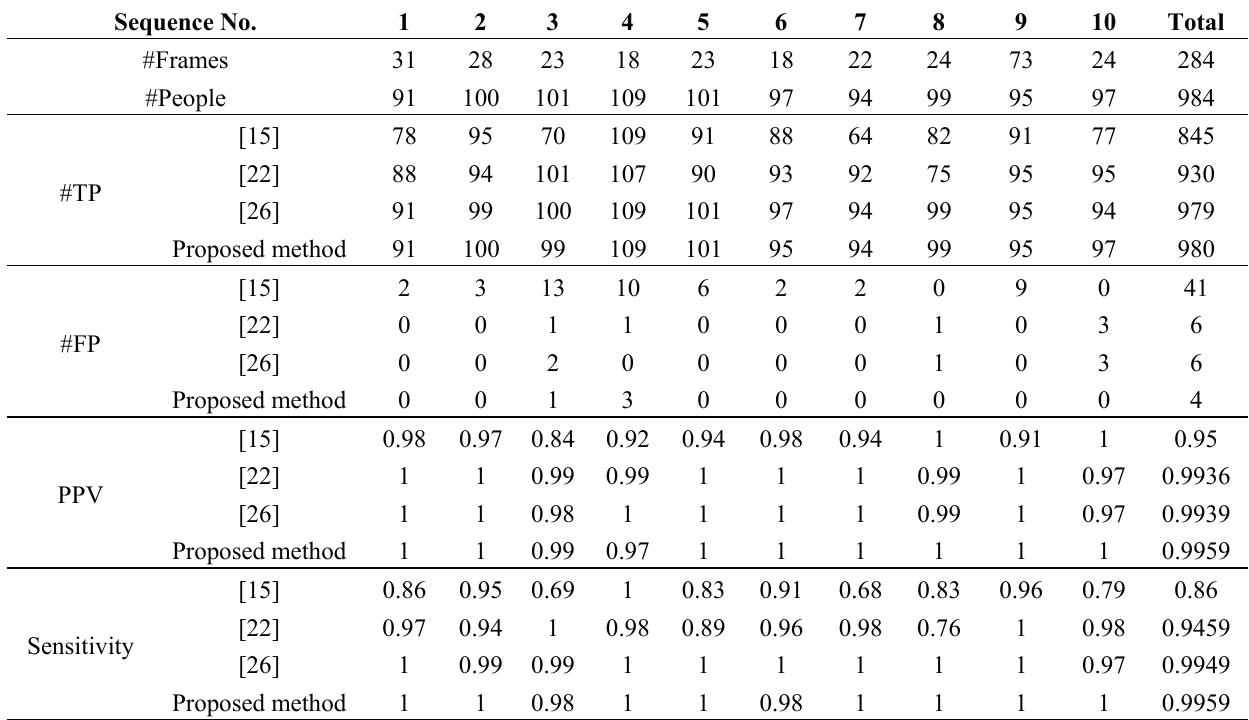
Table 2. Comparison of the detection results for the proposed method and other methods with the OTCBVS benchmark dataset. PPV, positive predictive